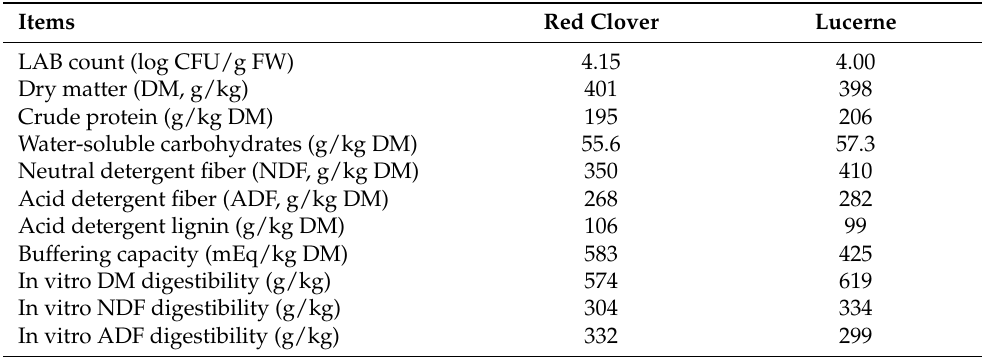
Table 3. Lactic acid bacteria (LAB) count, chemical composition, and in vitro digestibility of red clover and lucerne prior to ensiling (n =